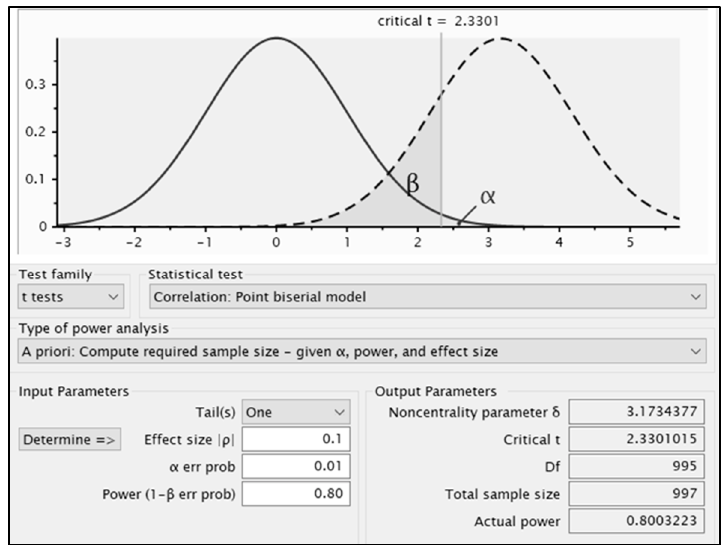
Figure 5. Minimum sample size. G-Power.